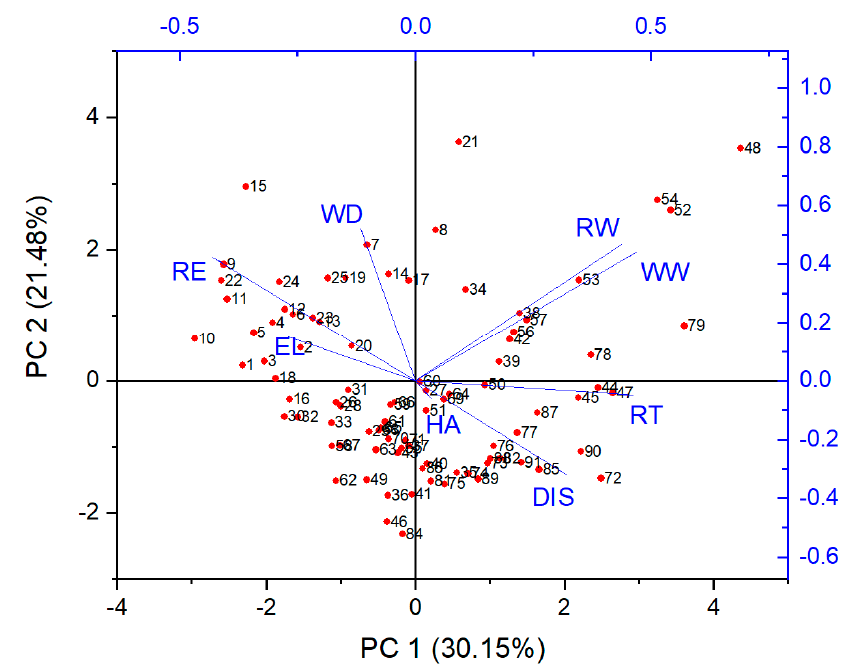
Figure 4. Ordination biplot of fish species composition and geographical and environmental variables based on the principal component analysis (PCA) at every 89 site of the DMZ. Variables include RW, river width (m); WW, water width (m); WD, water depth (m); EL, elevation (m); HA, human activity and disturbance; RE, survey regions; RT, river type; and DIS, districts.